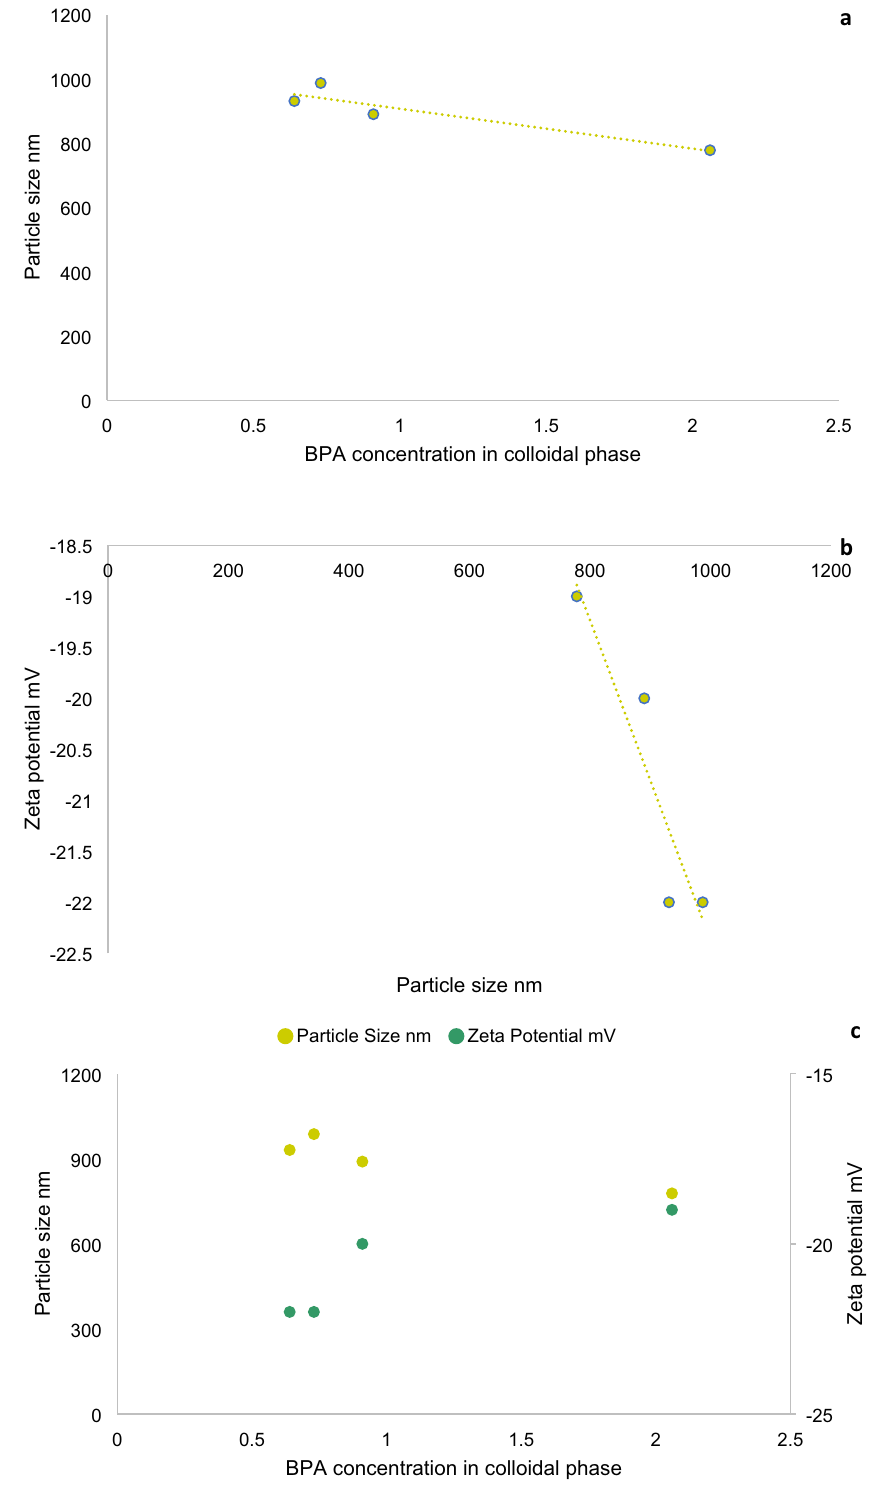
Figure 8. Correlations between ( A ) BPA conc. in the colloidal phase and PSD, ( B ) PSD and zeta potential and ( C ) BPA, PSD and zeta